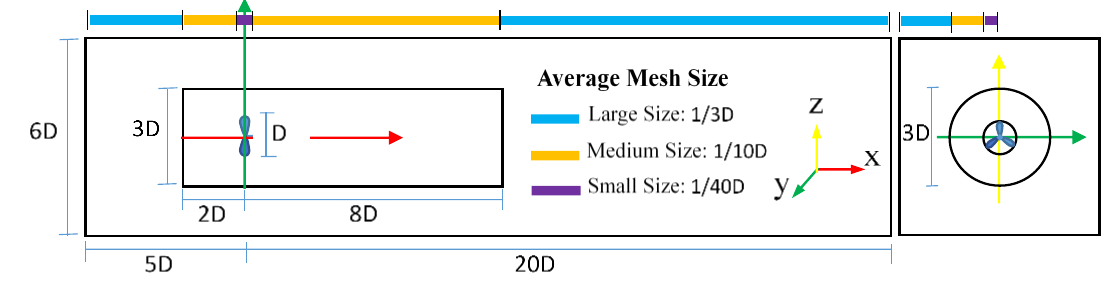
Figure 6. Calculation domain dimension design.